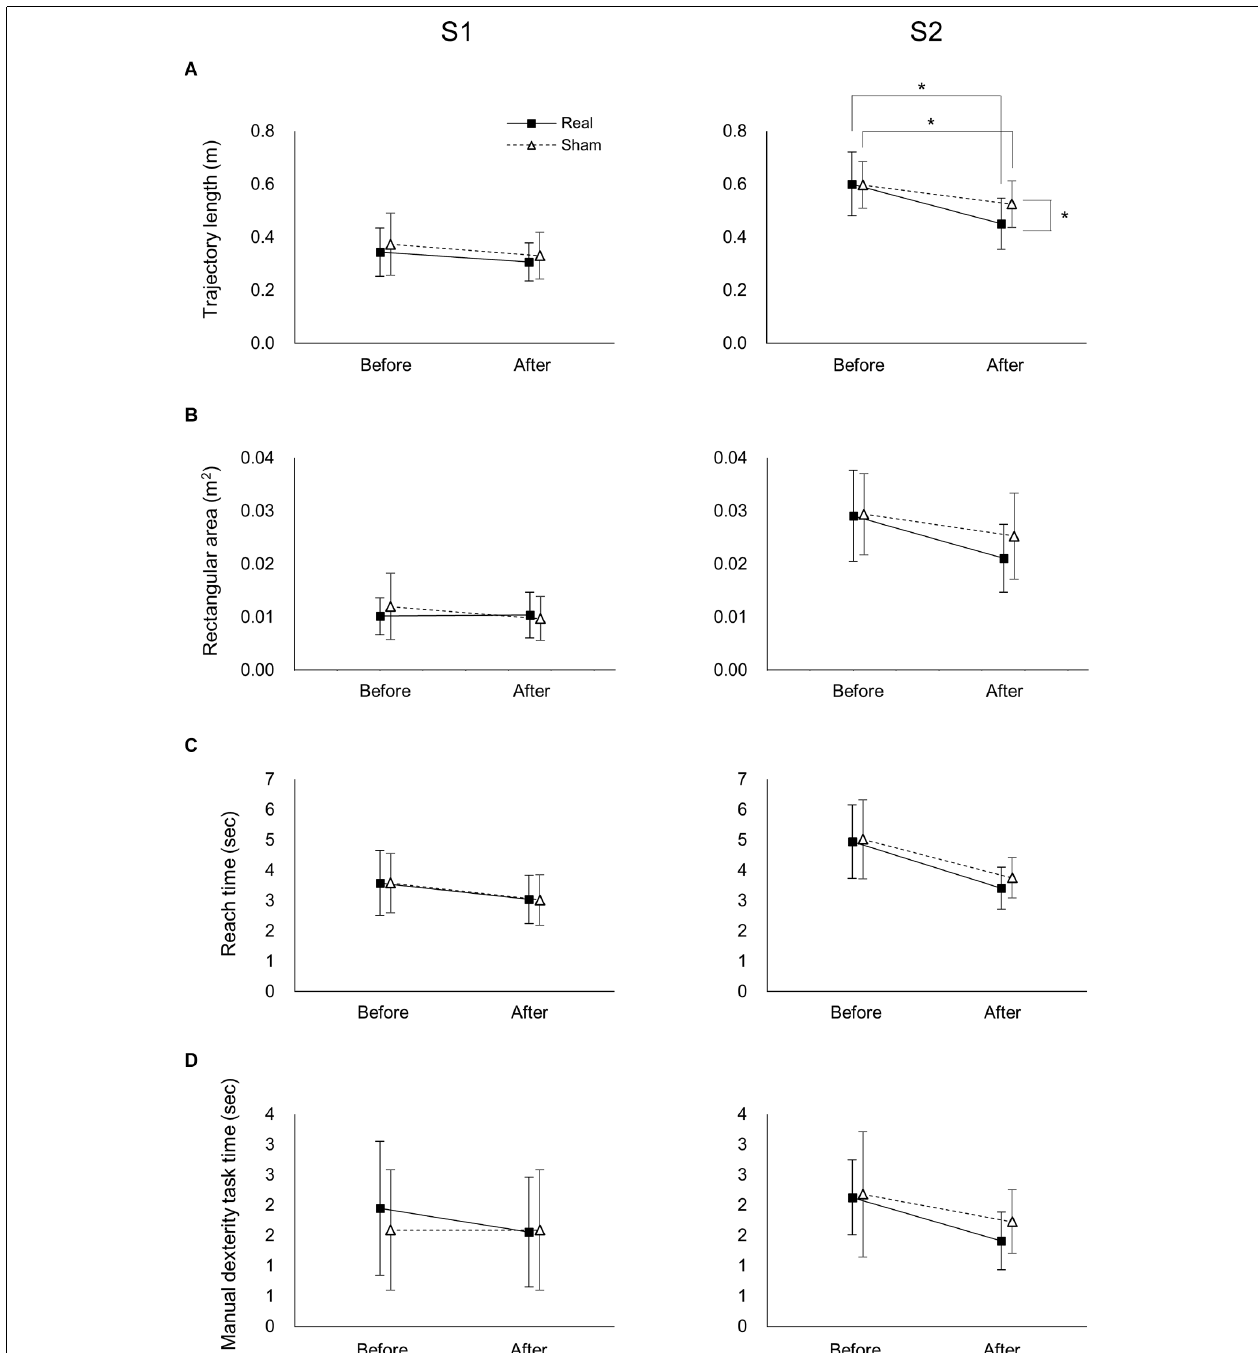
FIGURE 4 | Effects of tDCS on the trajectory, reach time, and manual dexterity task time of the real and sham groups before and after tDCS. Effects of tDCS on trajectory length (A) , rectangular area (B) , reach time (C) , and manipulation time (D) on S1 (left panel) and S2 (right panels). Data represent mean ± SD. *Indicates p <